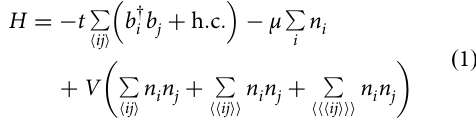
y ( b i ) creates (annihilates) a hard-core boson at site i , and where b i ¼ b y n b measures the number of bosons therein. The t term i i i hops bosons between neighboring sites and the V terms are repulsive interactions between any two bosons on a hexagon, see Fig. 1a. By the mapping b